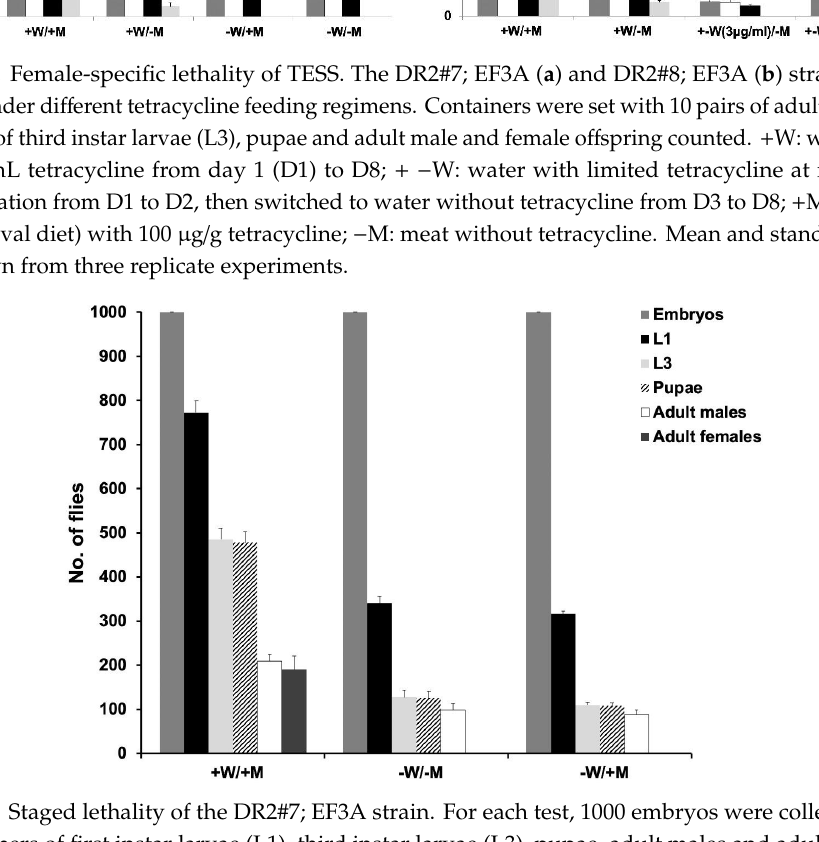
Figure 4. Staged lethality of the DR2#7; EF3A strain . For each test, 1000 embryos were collected and the numbers of first instar larvae (L1), third instar larvae (L3), pupae, adult males and adult females were recorded. Error bars show the mean and standard error ( n = 3). +W/+M: parental water contained 100 μg/mL tetracycline and the larval diet (93% ground meat) contained 100 μg/g tetracycline; −W/−M: neither adult nor larval diets contained tetracycline; −W/+M: the adult diet lacked tetracycline but the larval diet contained 100 μg/g tetracycline.